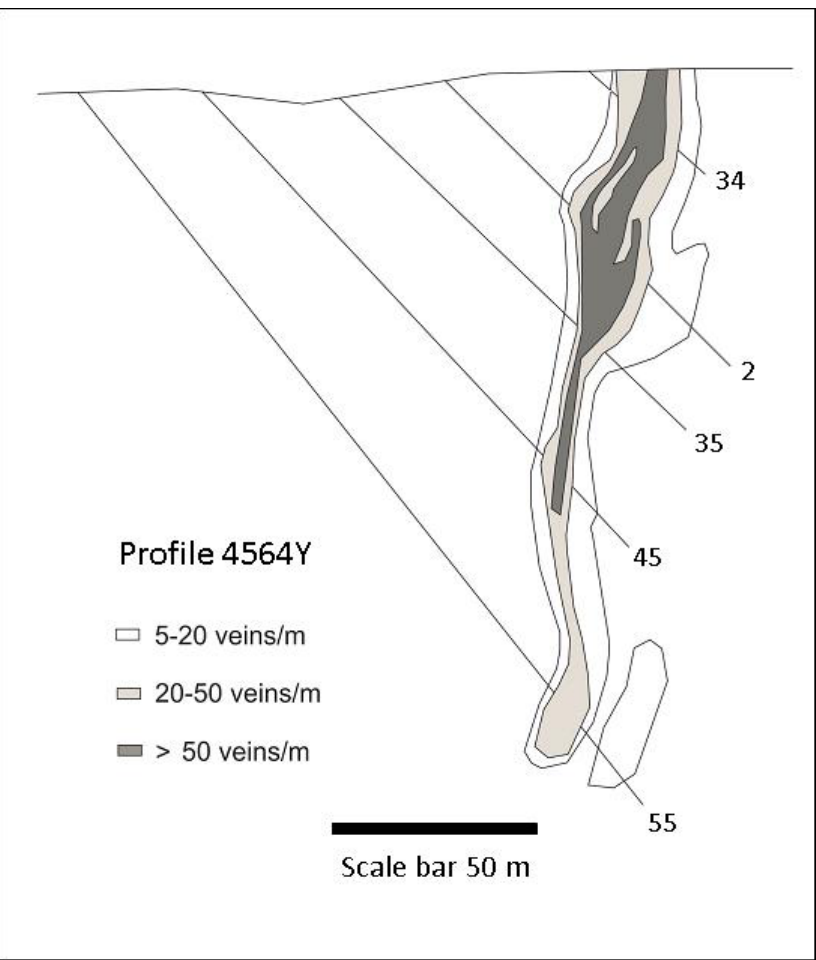
Figure 5. Vertical profile showing that inner parts of mineralised zones typically are characterized by an elevated number of quartz